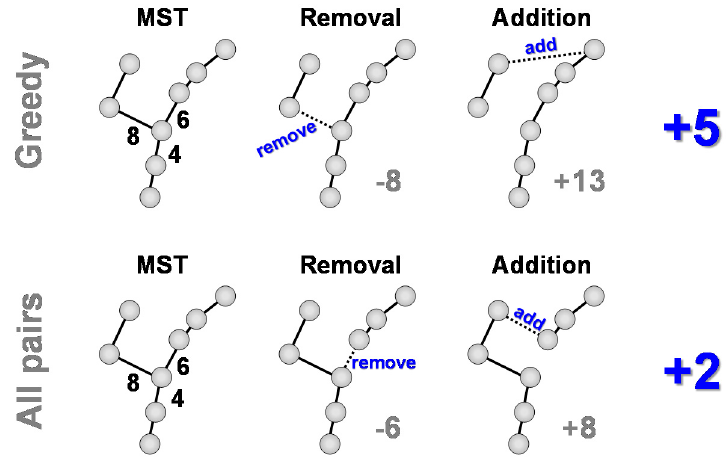
Figure 12. Example of the Greedy and All-pairs variants. Greedy removal leads to the same sub- optimal result as TSP-Kruskal while allowing to remove shorter link, the optimal solution can be easily reached.